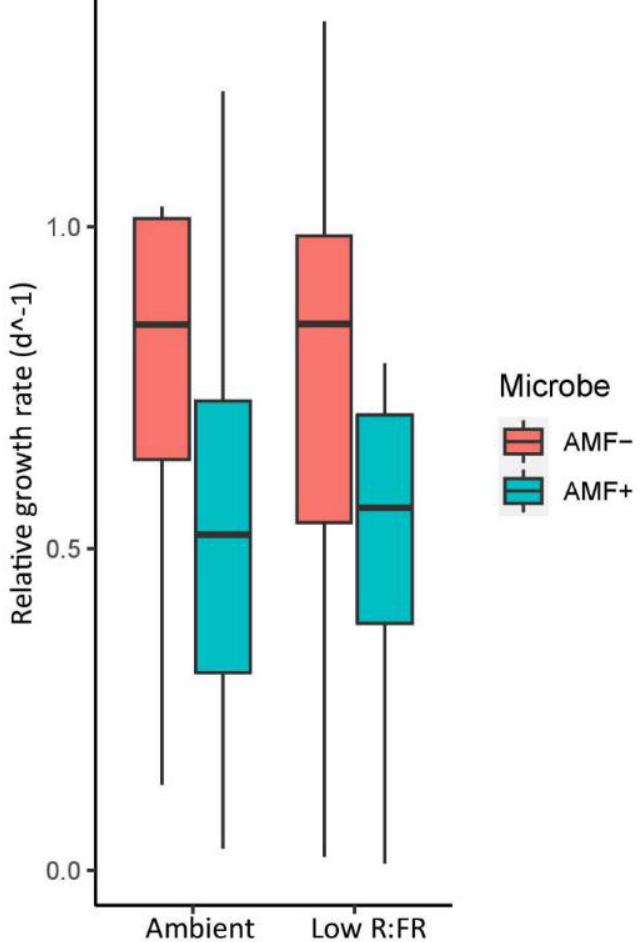
Figure 4. Relative growth rate (RGR) of unparasitized Spodoptera exigua feeding on tomato plants grown under two light (Ambient, Low R:FR) and two inoculation treatments (AMF − : no mycorrhiza, AMF+: mycorrhiza). RGR = (lnW[final]) − lnW[initial])/ t . W = weight, t = time in days. The error bar denotes 1SE. No significant differences were observed in RGR across light and inoculation treatments. The median is represented by the thick horizontal line; the box is defined by the 25th and 75th percentiles (lower and upper quartile).